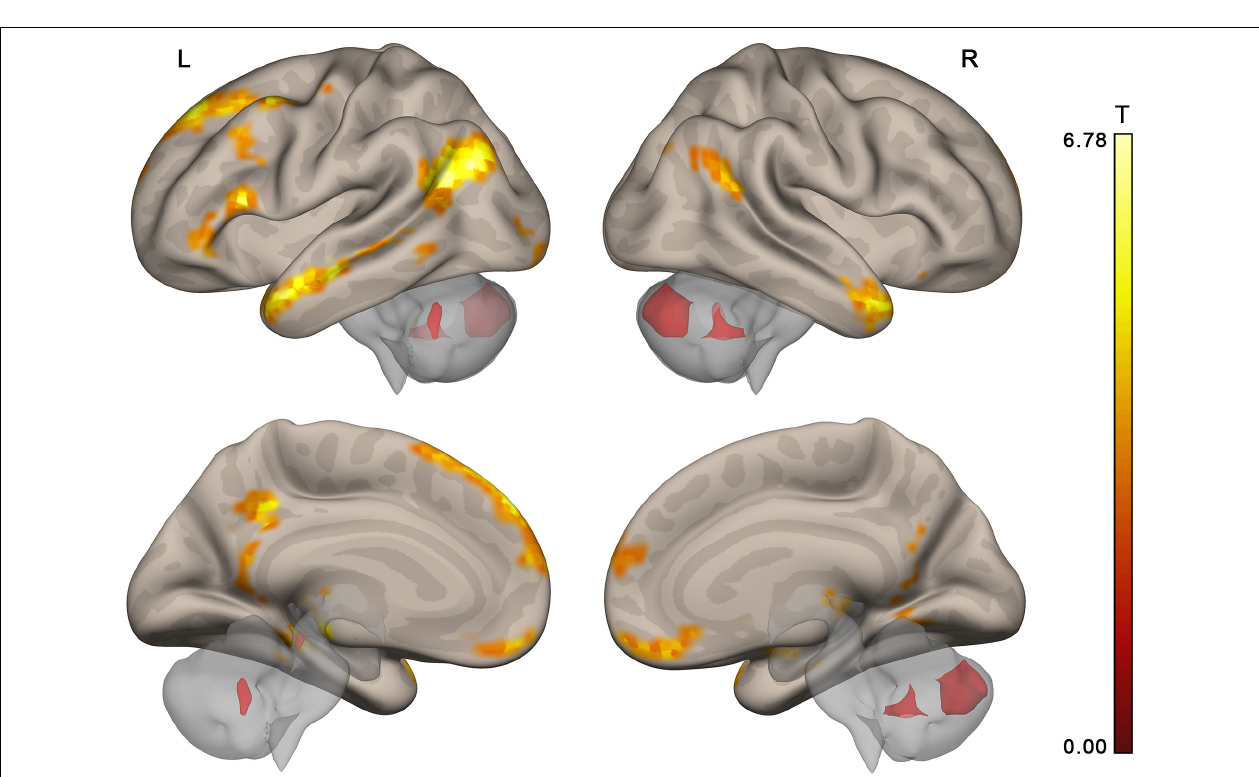
FIGURE 6 | Brain activation specific to discourse comprehension compared to individual word comprehension revealed in a control experiment (contrast “actual discourse > scrambled discourse,” group random effect analysis, N = 24, voxel-wise FDR-corrected level p < 0.05, q < 0.05, extent threshold k = 10) overlaid over the MNI-space brain template. Voxels activated by scrambled speech vs. resting baseline were excluded from the analysis at the single subject level with a threshold of p < 0.05 (uncorrected).